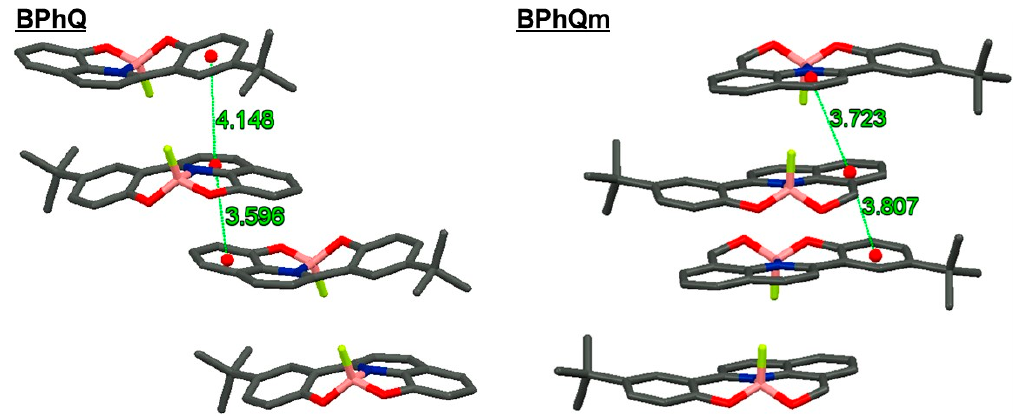
Figure 3. Packing structures of BPhQ ( left ) and BPhQm ( right ) ( gray , carbon atoms; blue , nitrogen atoms; red , oxygen atoms; pink , boron atoms; yellow , fluorine atoms. Hydrogen atoms are omitted for clarity).